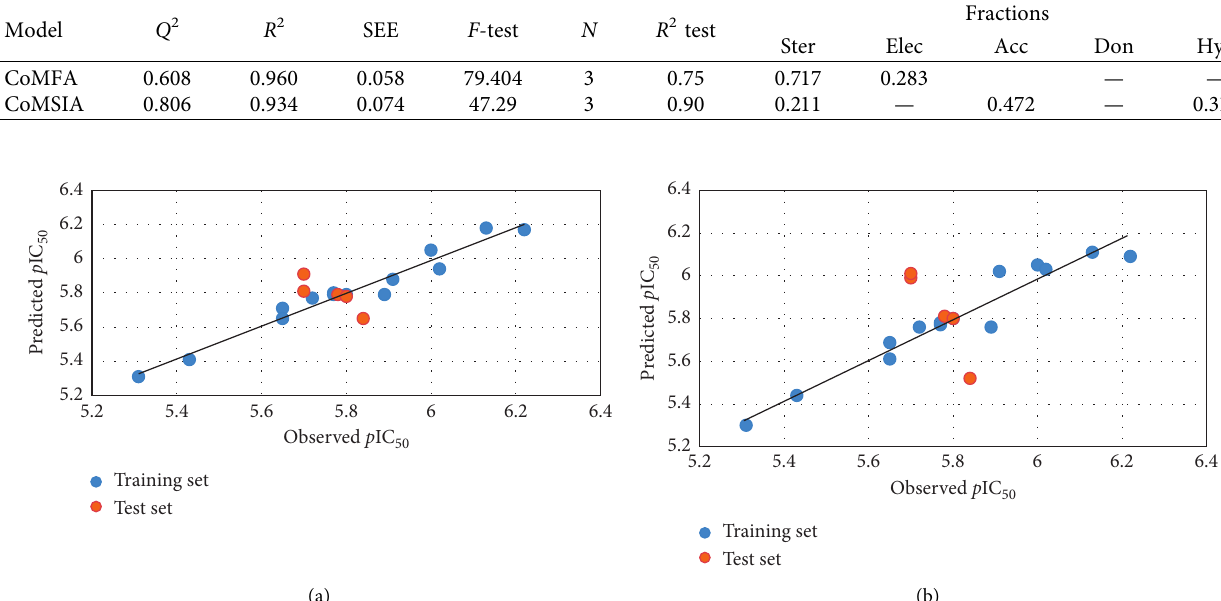
Table 4: Calculated data for the 3D-QSAR model.